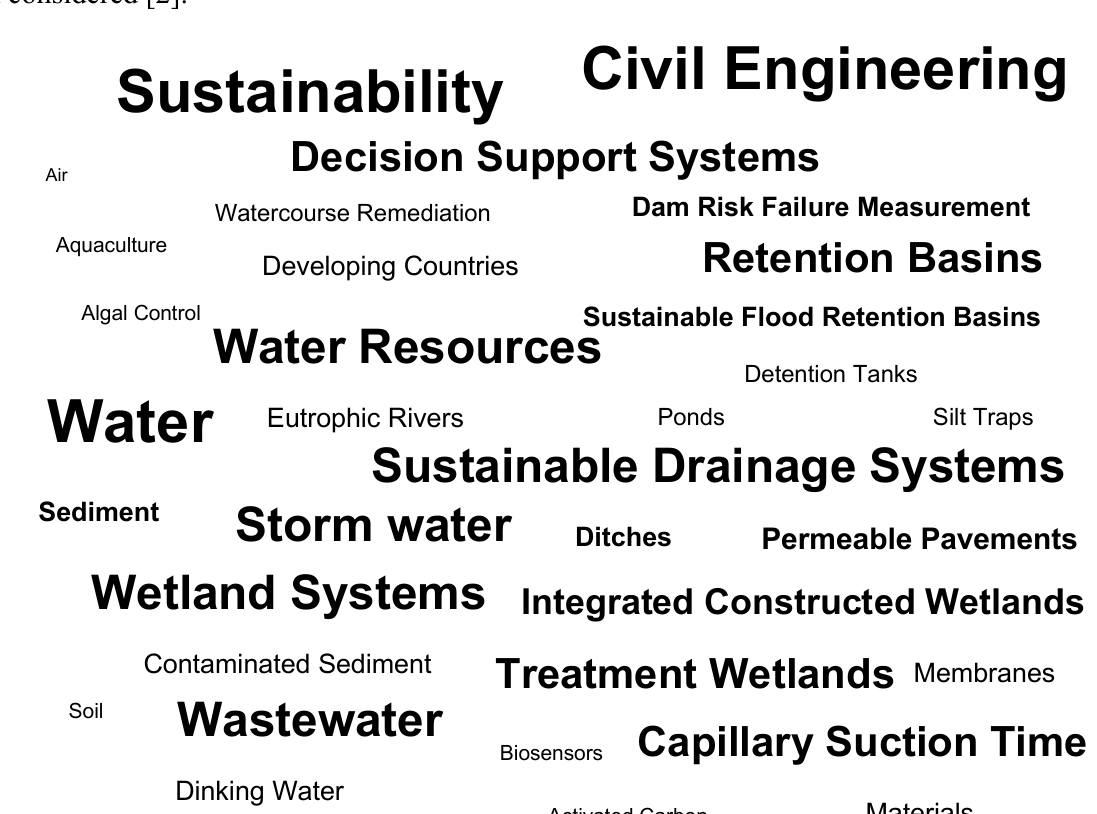
Figure 1. Overview of special issue research areas and their corresponding relative importance (the larger and bolder the font the more important), and linkages (the closer located to each other the more related) between